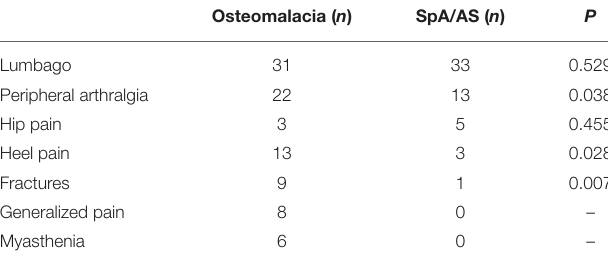
TABLE 2 | Clinical symptoms of patients in both